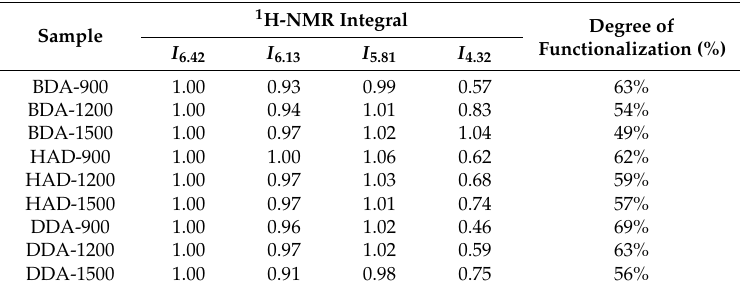
Table 3. H-NMR integrals and degrees of functionalization of OL-As.